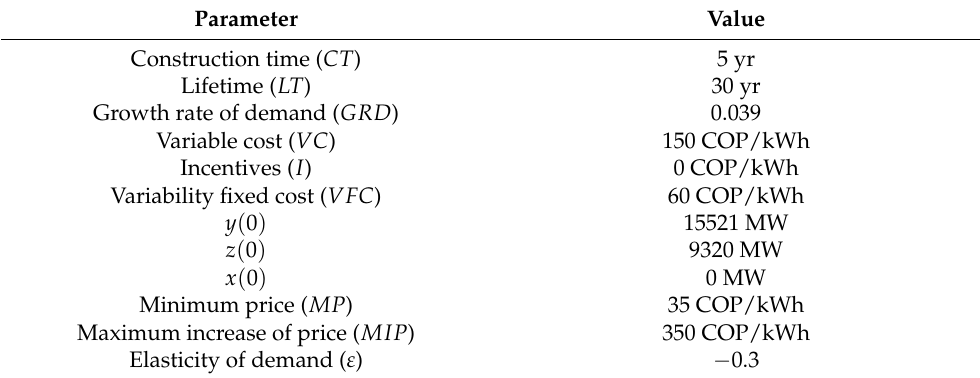
Table A1. Parameters used in the model based on the Colombian electricity sector